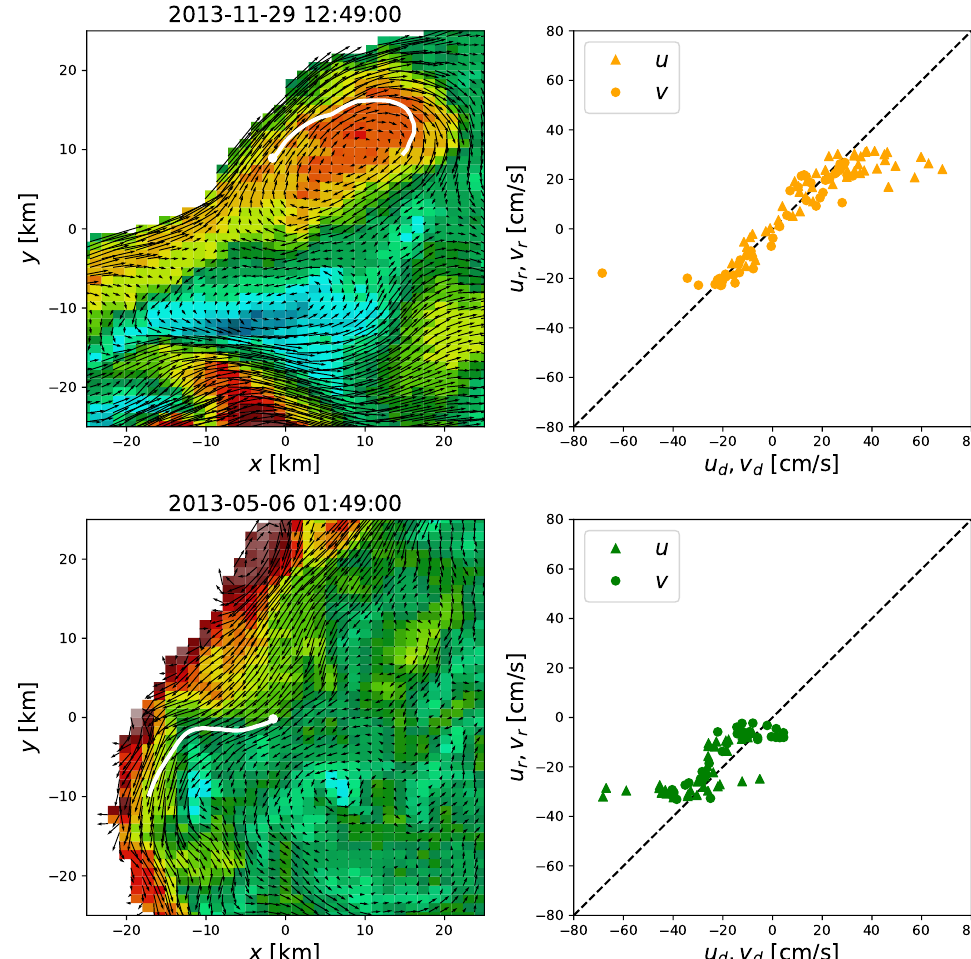
Figure 6. ( Left ) BT of coastal coherent structures with the reconstructed velocity field. White line indicated the trajectory of the drifter used for the scatter plot of the second line and the metrics shown in Table 1. ( Right ) Scatter plot between velocities derived from drifters and those obtained from the BT images. White areas correspond mainly to land